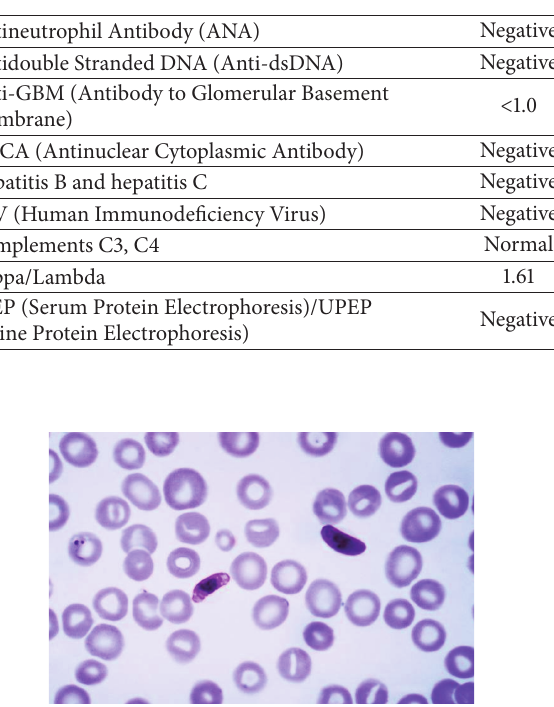
Table 1: Glomerulopathy laboratory tests.